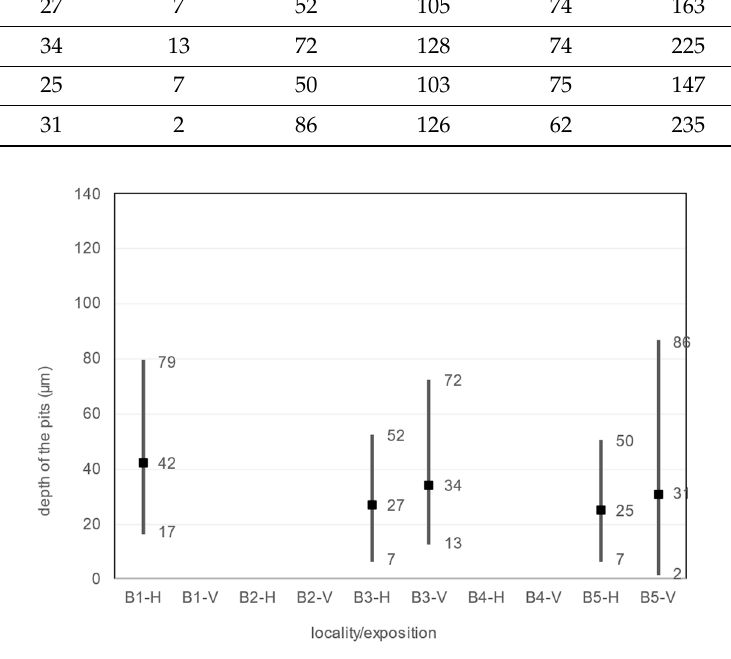
Figure 16. Depth of the pits.